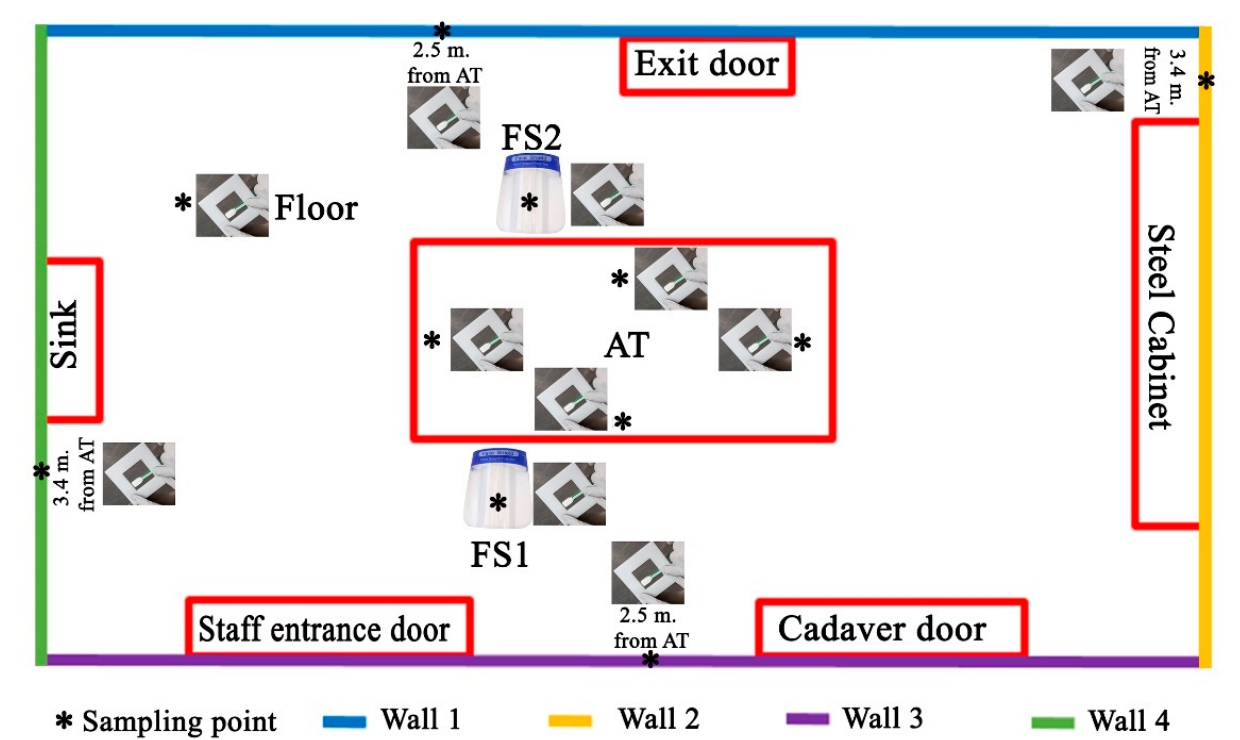
Figure 1. The scheme of environmental sampling of the autopsy room (A.R.): as indicated in the main text, for each autopsy 11 swabs were sampled.